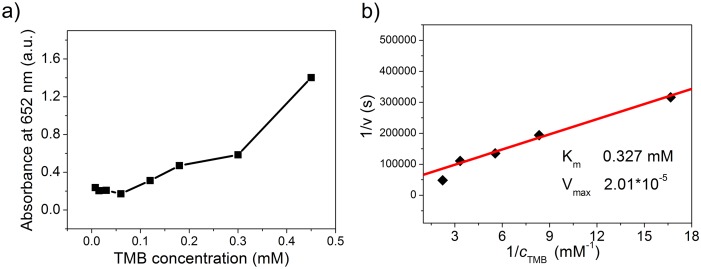
Steady-state kinetic assay of the Ag3PO4 nanocrystals.a) The concentration of H2O2 was 5 mM and the TMB concentration was varied. b) Double reciprocal plots of 1/V ∼1/CTMB. Reaction conditions: 2 mg/mL of Ag3PO4 in 5 mL of NaAc buffer with pH 4.0 at 25°C.